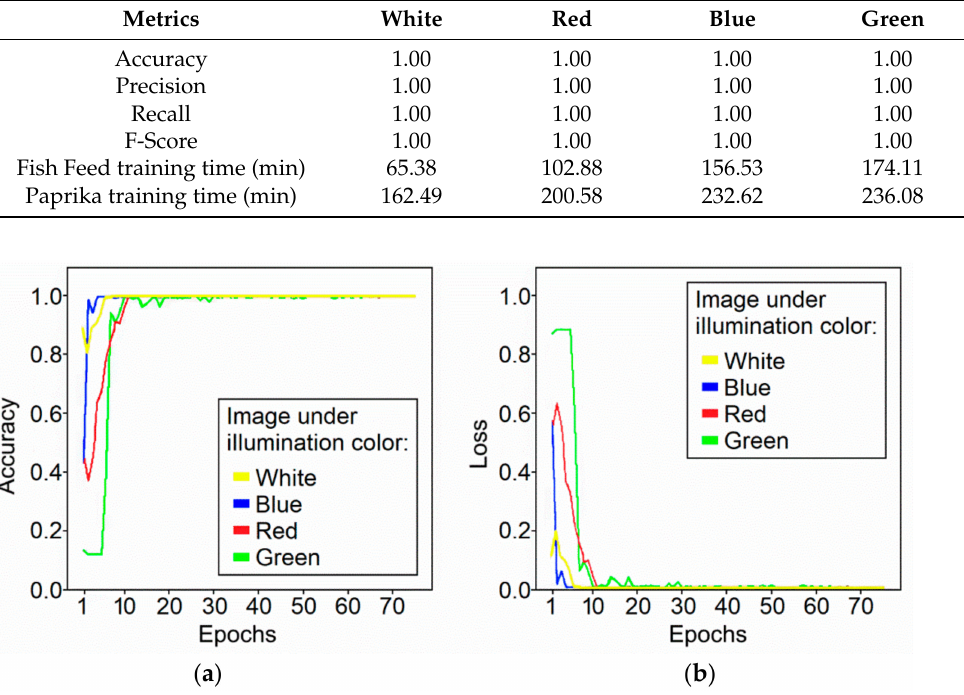
Figure 10. ( a ) Classifier training accuracy for each validation color dataset. ( b ) Loss for each validation color